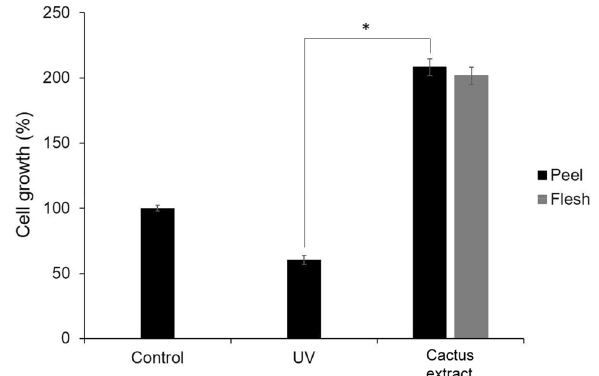
Figure 3. Ultraviolet protective effect of cactus extract (peel and flesh) on B16-F10 cells by MTT assay. All data are presented as the mean ± S.D. of three independent experiments. * P < 0.05, ** P < 0.01 compared with control group.